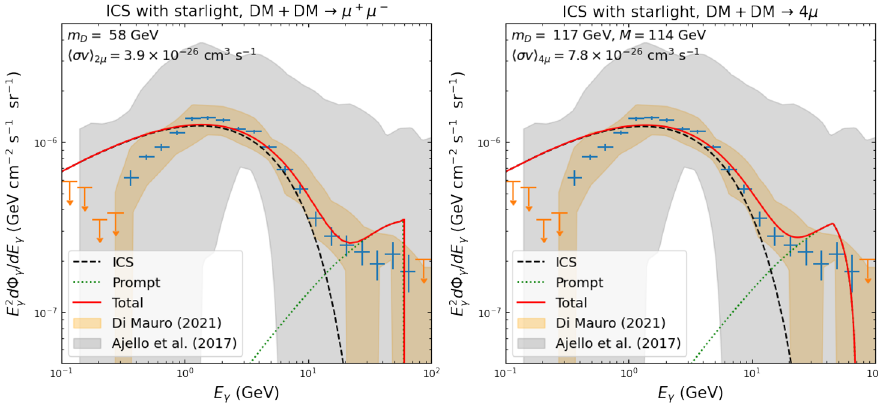
Figure 1 . The gamma-ray flux component for ICS (black dashed line) and prompt emission (green dotted line) from DM annihilation to µ + µ − (left panel) and 4 µ (right panel) final states. The combination of ICS and prompt emission is represented by red solid line. The DM mass m mediator mass M , and annihilation cross sections h σv i blue and the orange GCE data points are reported in ref. [12], only blue data points are considered in our χ 2